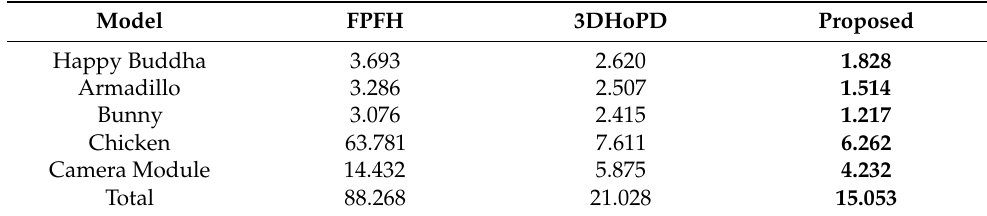
Table 5. Comparison of the registration times of all algorithms for the five